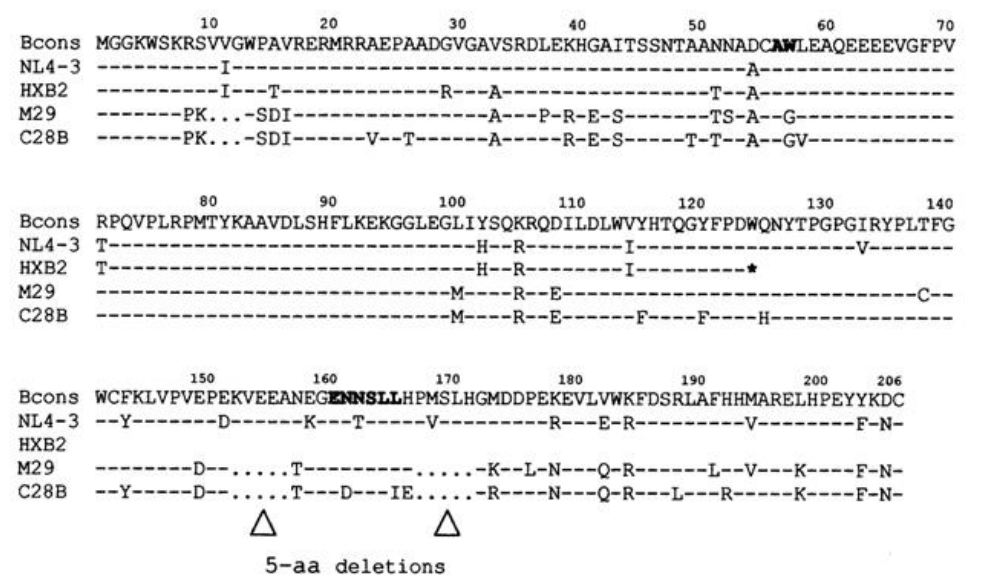
Figure 1. Clustal alignment of Nef sequences. Amino acid sequences for mother (M29) and child (C28B) Nefs were aligned with HIV-1 subtype B Nef consensus (Bcons) and Nefs HIV-1 using Clustal X. Dots indicate gaps inserted to facilitate alignment. Dashes indicate HIV-1 HXB2 homology with B consensus. The stop codon in HIV-1